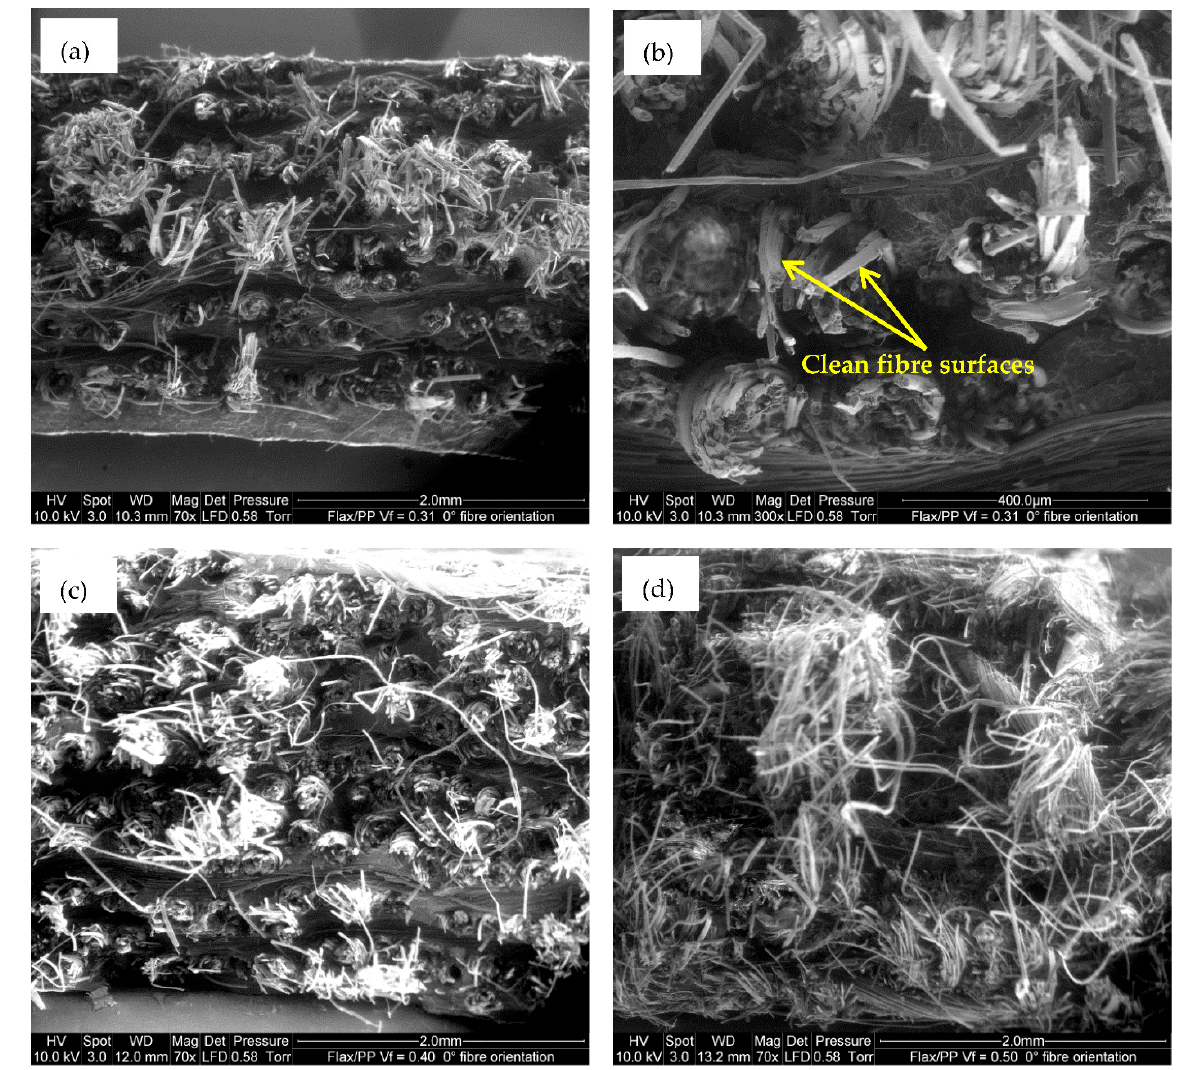
Figure 19. Tensile fracture surface images: ( a , b ) showing fibre pull-out for a fibre volume fraction and orientation of 0.31 and 0°, respectively, at two different magnifications, and ( c , d ) showing fibre pull-out for fibre volume fractions of 0.40 and 0.50, respectively, with a 0° fibre orientation.